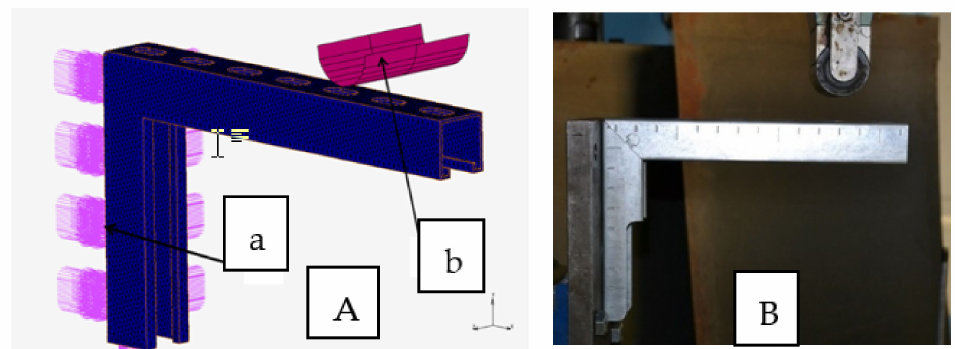
Figure 9. Concept of the console load: ( A ) numerical model (a—fastening, b—loading pin); ( B ) method of experimental implementation of the numerical